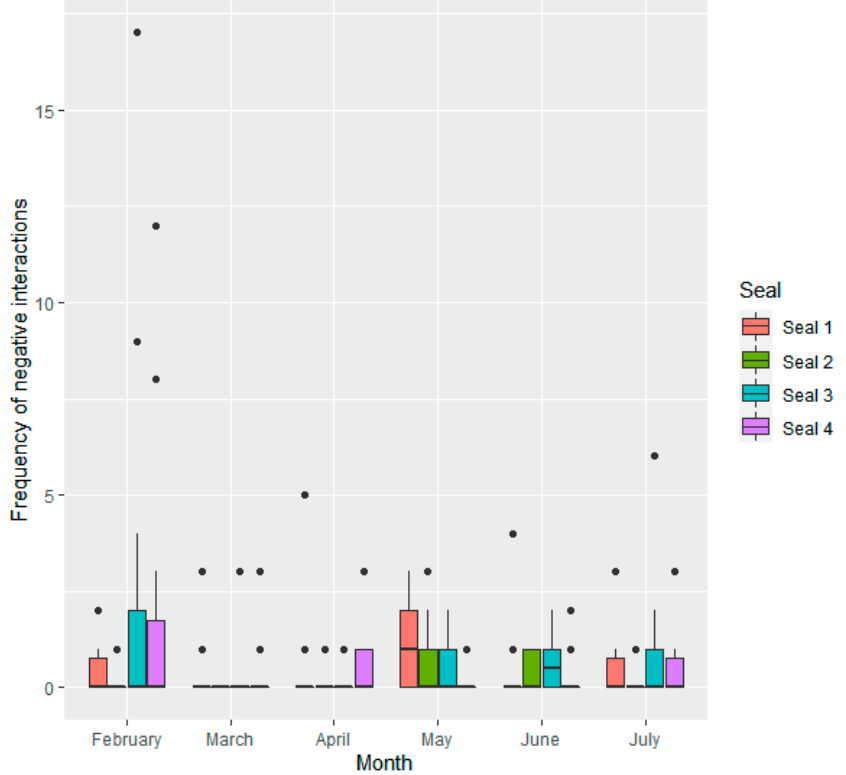
Figure 3. Frequency of negative social interactions given by each seal ( n = 4) per observation period.